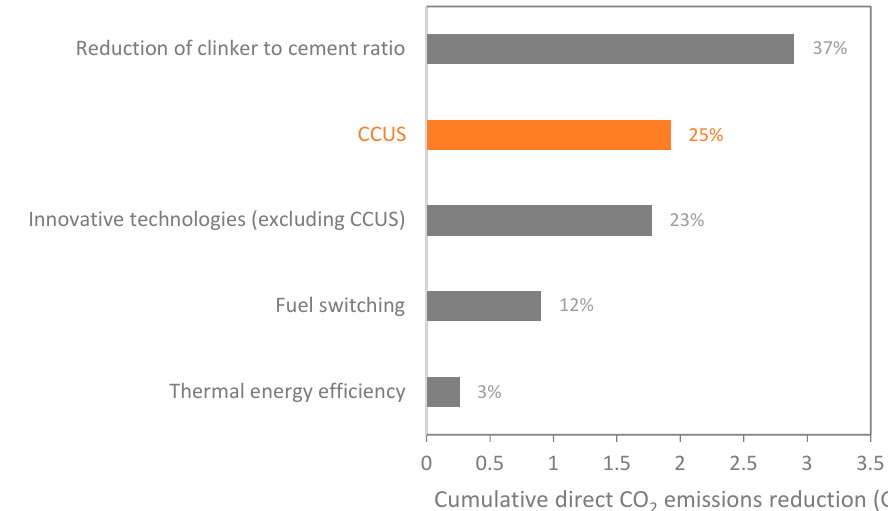
Figure 2. Global cumulative CO 2 emissions reductions by 2050 (2DS versus RTS) (adapted from [3]).